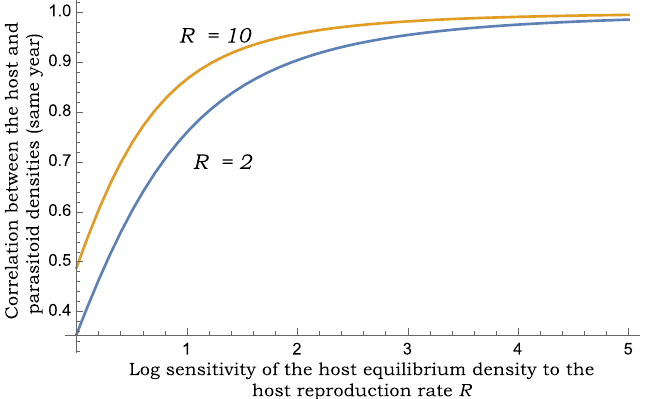
Figure 2. Randomness in host reproduction induces strong positive correlations between host-parasitoid densities for model (3)–(4) that incorporates heterogeneity in parasitism risk. Predicted Pearson correlation coefficient between the host and parasitoid densities for R = 2 and R = 10 as a function of H R as given in